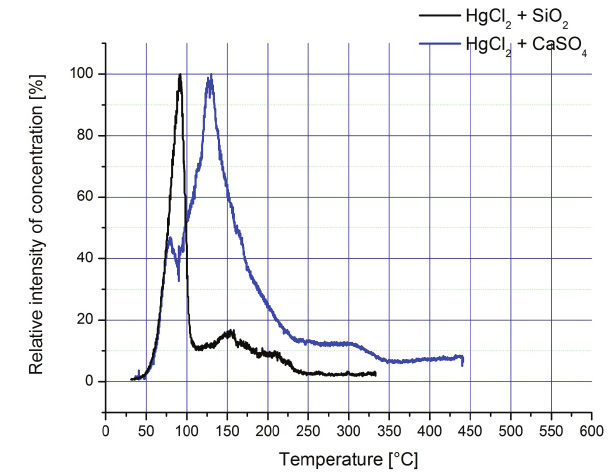
mixtures, obtained by 2